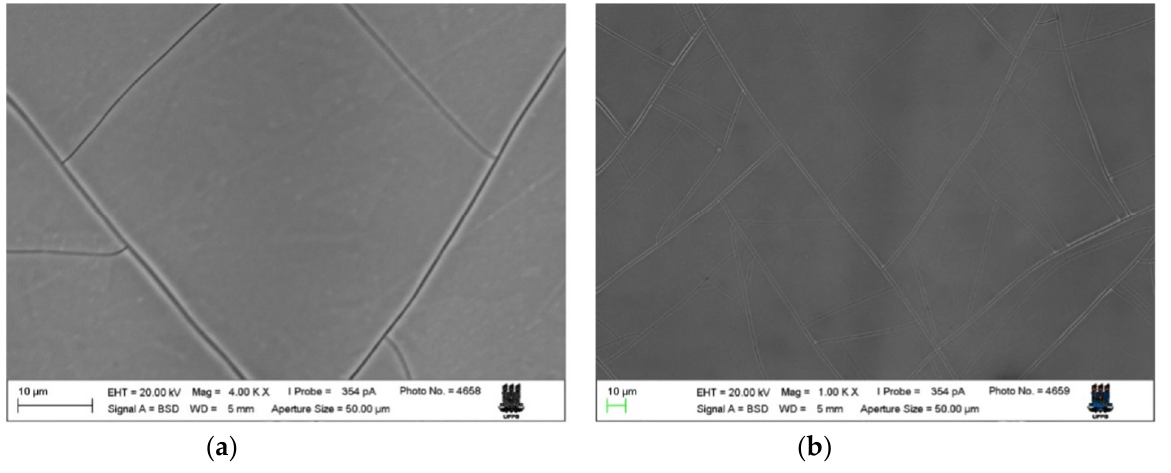
Figure 11. Scanning electron microscopy for samples with EP (electropolishing) treatment and 1 min deposition time. Magnifications: ( a ) 4000×; ( b ) 1000×.